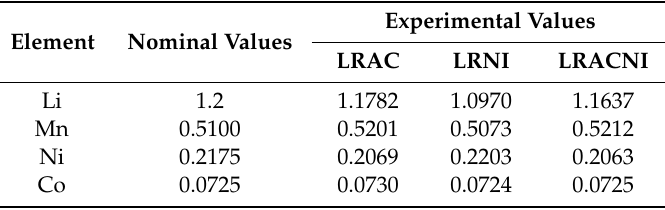
Table 1. ICP-MS data for LRAC, LRAC, and LRNI cathode materials.